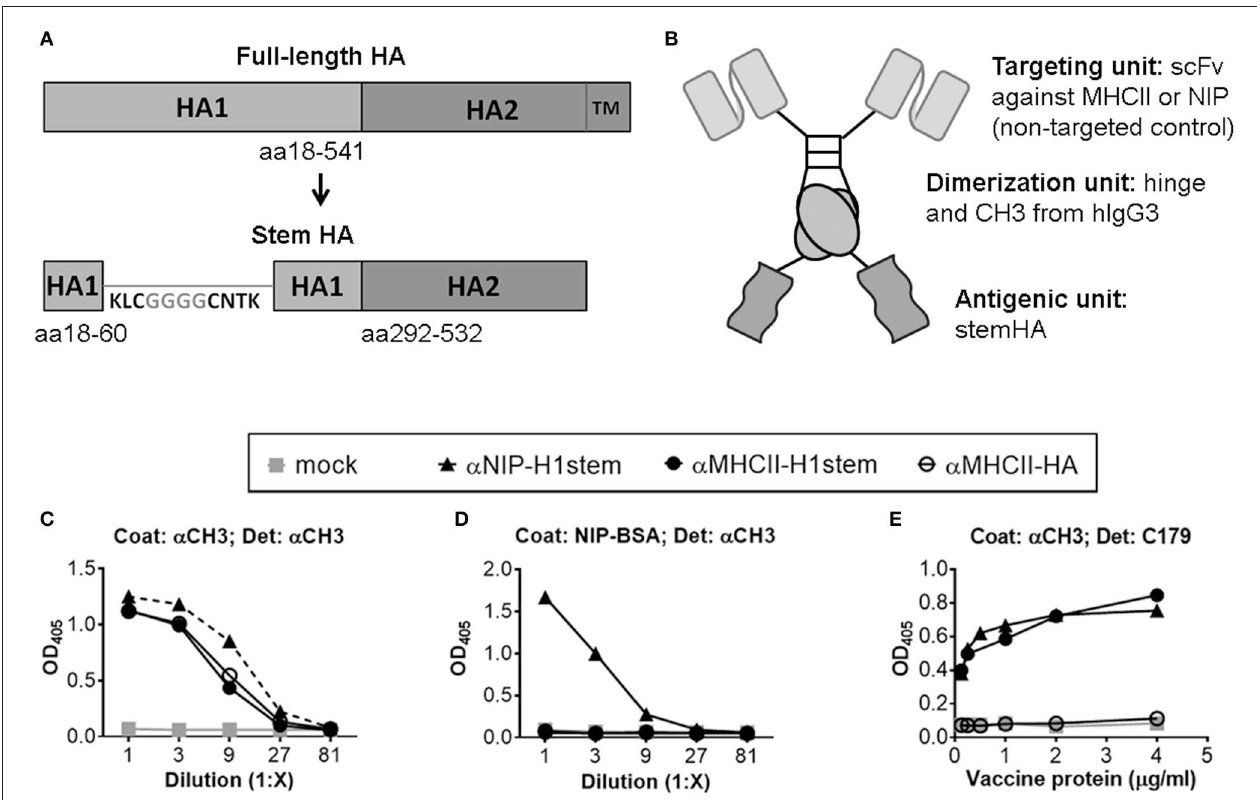
FIGURE 1 | Characterization of vaccine molecules. (A) Schematic of the linear structure of the full-length HA protein (top), and the vaccine-inserted HA stem domain (bottom). Inserted amino acids are shown in gray, while amino acids present in the native HA sequence are in black. (B) Schematic structure of a dimeric vaccine protein. (C,D) Supernatants of transfected 293E cells were examined by ELISAs using either a mAb against C H 3 (C) or NIP-BSA (D) as coat. Proteins were detected with a biotinylated mAb against C H 3. (E) Purified vaccine proteins were assayed in an ELISA coated with a mAb against C H 3, and detected with mAb against the stem region of HA